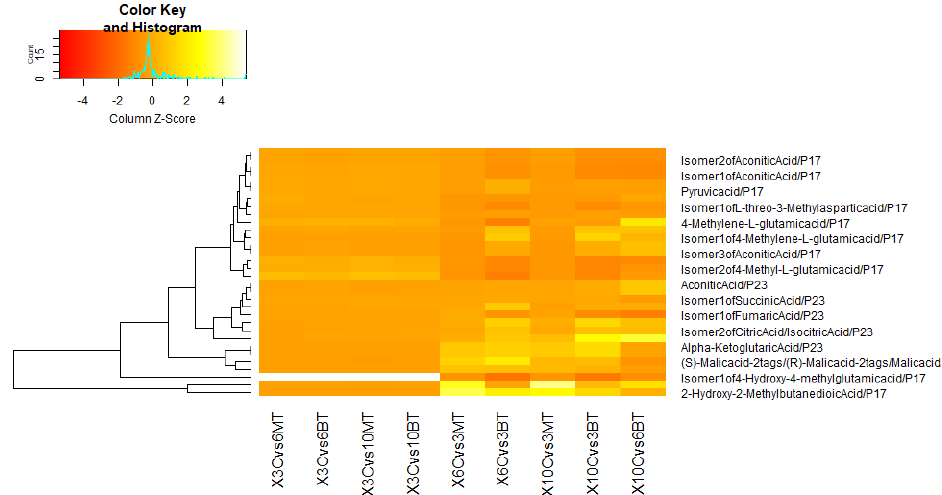
Figure 8. Heat map showing the differentially expressed metabolites of Tyrosine metabolism path- way (P81) in different comparisons between positive control plants (C) and Metarhizium (MT) or Beauveria (BT) treatments at different Dpi. Z score is a measure of distance, in standard deviations, from the plate mean. A well with a Z score of 0 has the same raw value as the plate mean. A well with a Z score of 1.0 is exactly one standard deviation above the plate mean and a Z score of −0.5 is half a standard deviation below the plate mean.